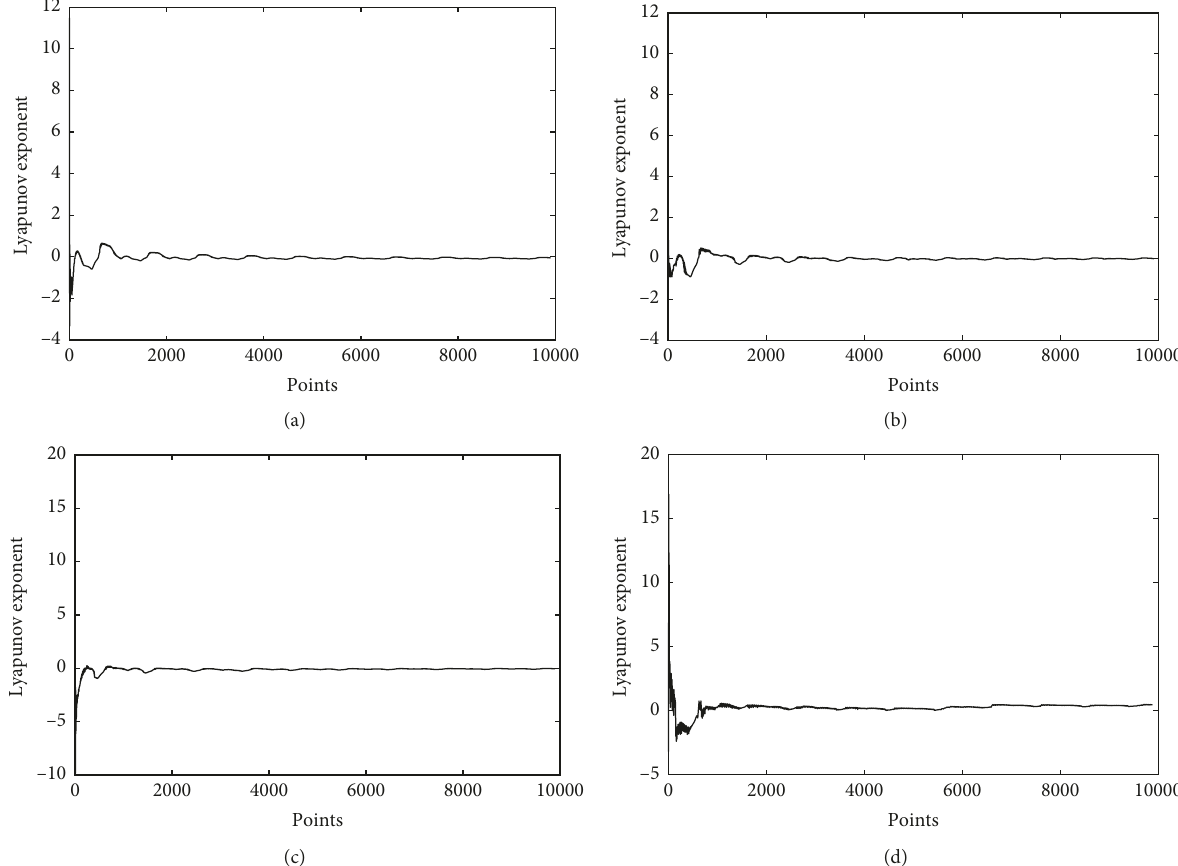
Figure 12: Lyapunov exponent of 2-DOF nine-bar mechanism for different clearance values: (a) clearance � 0.01 mm; (b) clear- ance � 0.05mm; (c) clearance � 0.1mm; (d) clearance � 0.2mm.